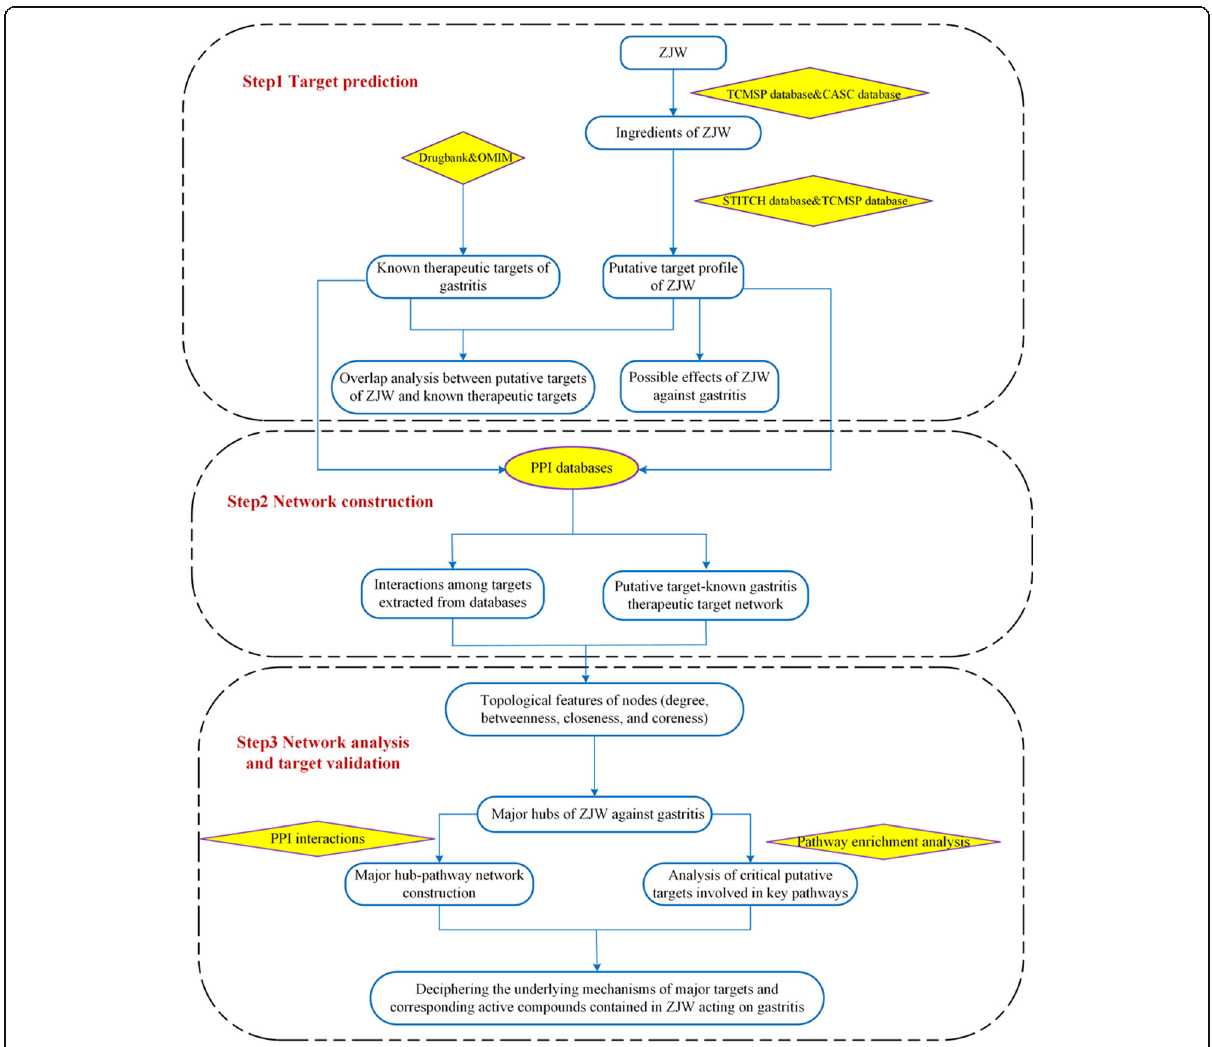
Fig. 1 The flowchart of network pharmacology-based strategy for deciphering the mechanisms of ZJW acting on gastritis. Abbreviations: ZJW, Zuojinwan; TCMSP, Traditional Chinese Medicine Systems Pharmacology; CASC, Chinese Academy of Sciences Chemistry; OMIM, Online Mendelian Inheritance in Man; PPI, protein – protein